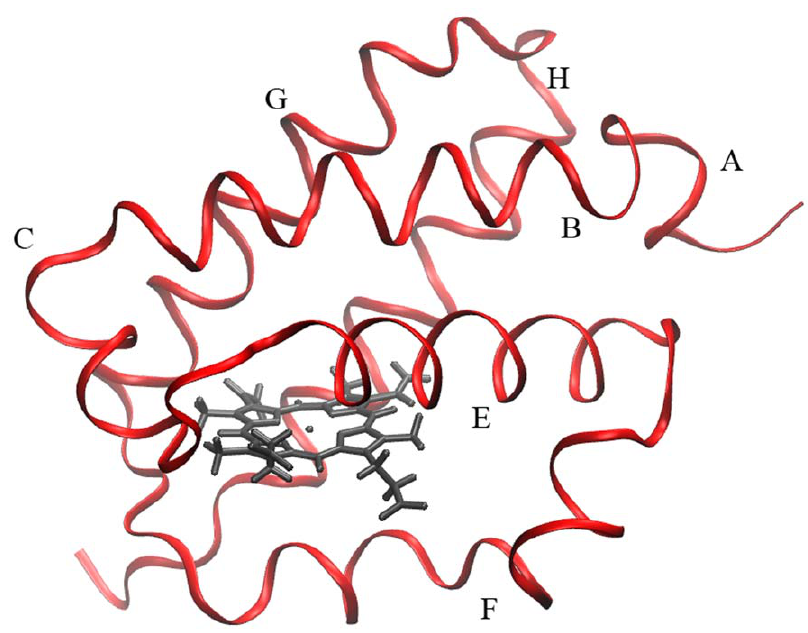
Figure 8. Schematic representation of the Tf -trHb structure.